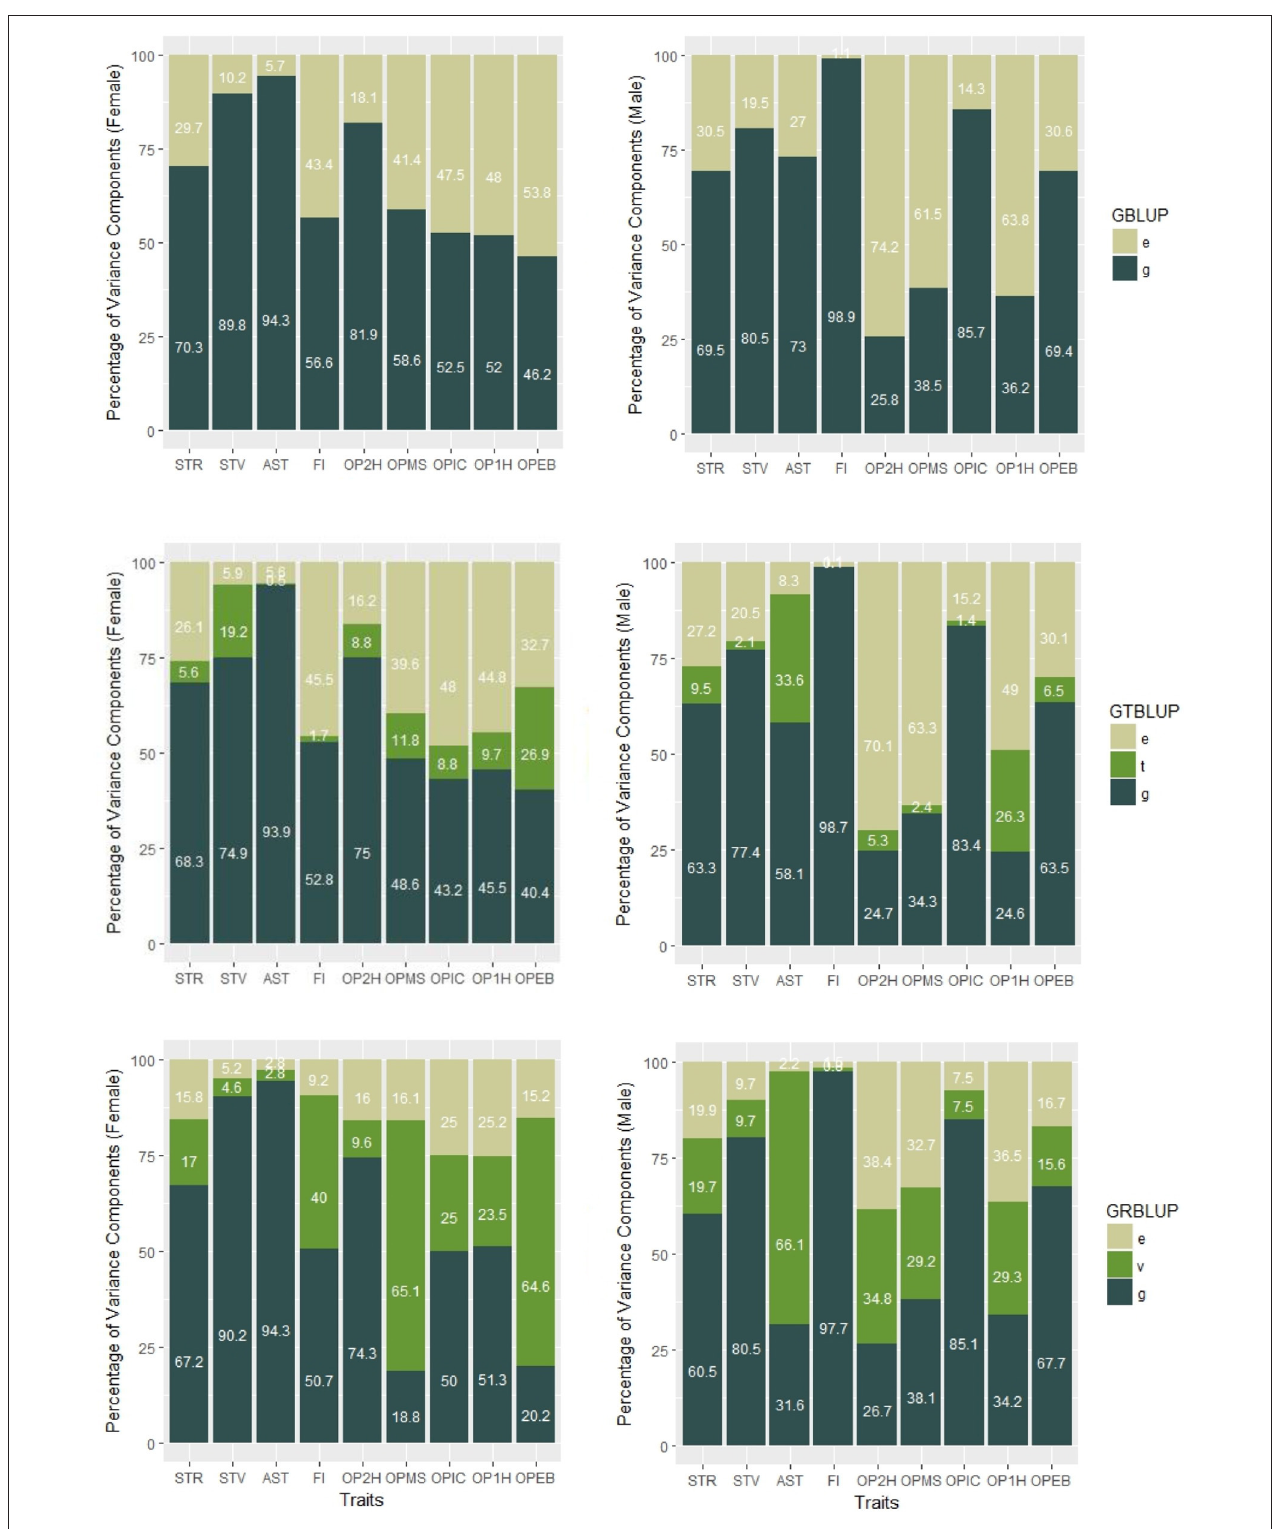
FIGURE 1 | Percentages of variance components of GBLUP, GTBLUP, and GRBLUP for nine traits for females (left) and males (right) . e is the residual; t is the transcriptomic line effect in GTBLUP; v is the transcriptomic line effect in GRBLUP, and g is the additive genetic effect captured by SNP data.